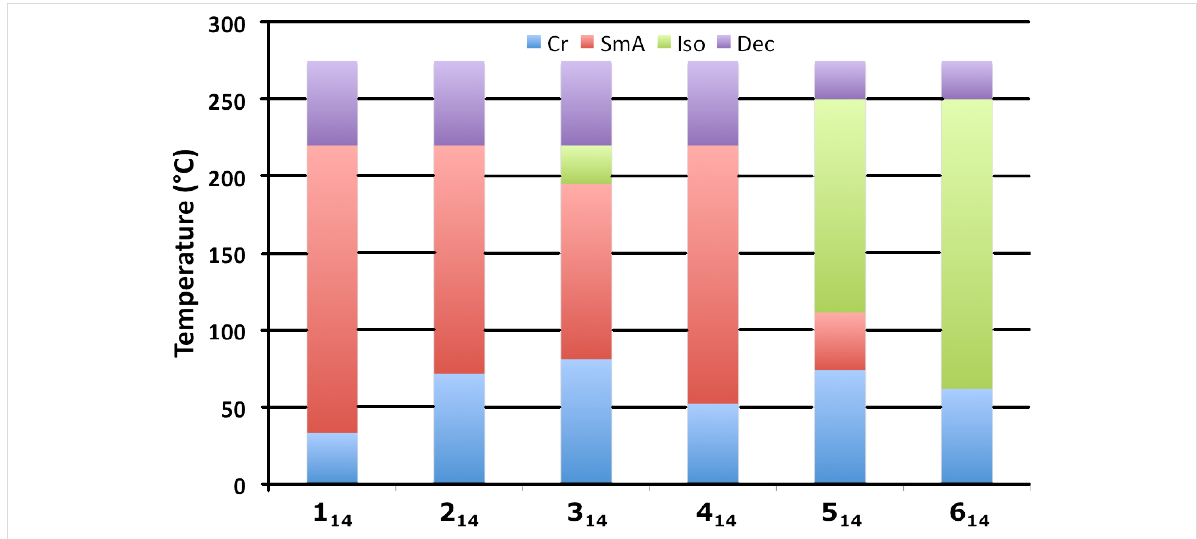
Figure 4: Transition temperatures of 1 14 – 6 14 as a function of the anion (Cr = crystal; SmA: smectic A phase; Iso: Isotropic Liquid; Dec: decomposi- tion).